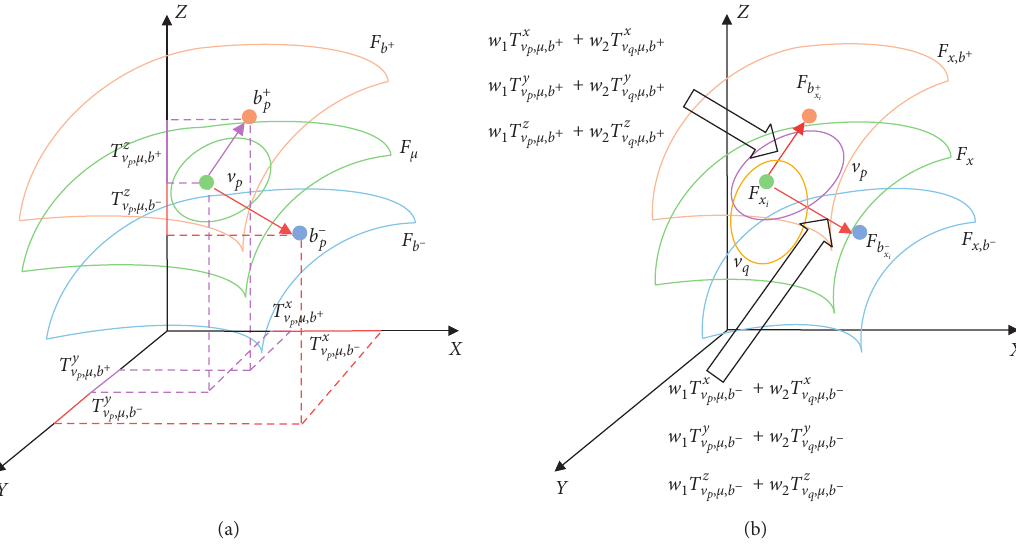
Figure 1: (a) Diagram for calculating the deviation value of each dimension in the dimension reduction result of a manifold with distribution parameters using the anchor vector v p and its locality as an example. (b) Assuming that x i is located in the local range of two anchor vectors v p and v q , this diagram calculates the deviation values of the dimension reduction result of x i .